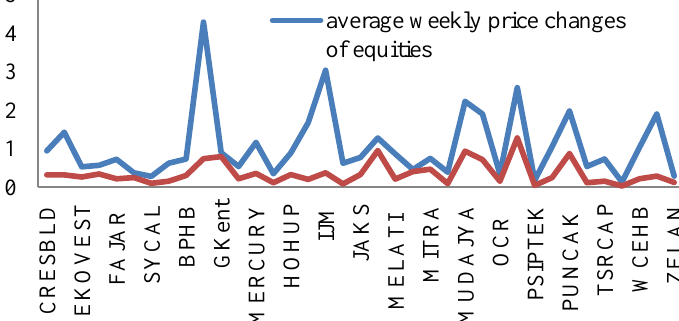
Figure 1. A plot of the mean and standard deviation of weekly price changes of